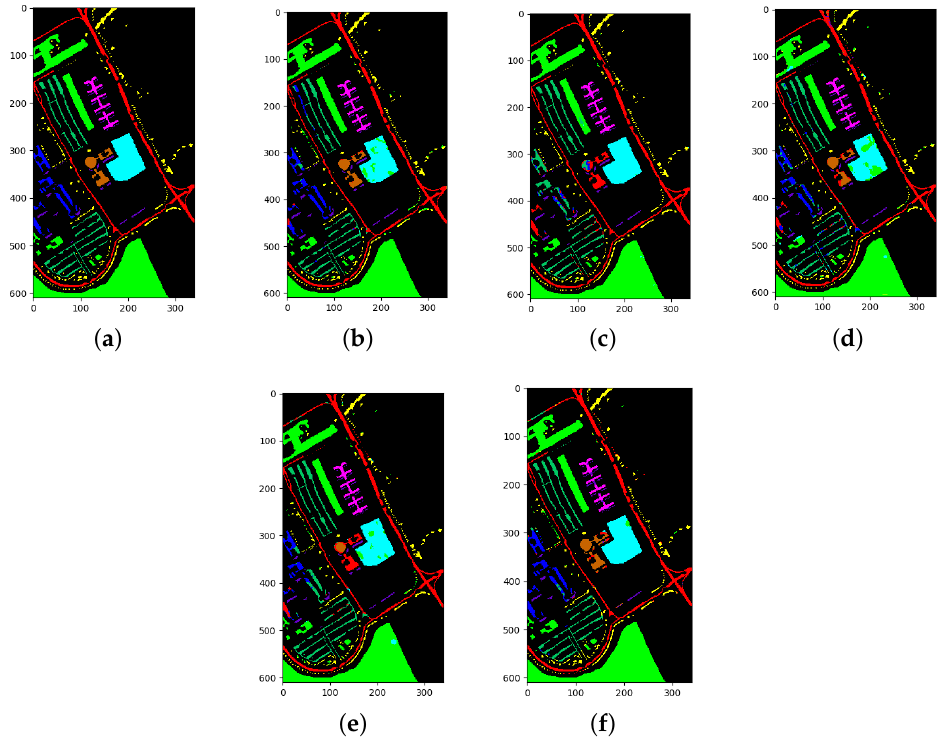
Figure 7. Classification maps for the PU dataset: ( a ) ground truth (GT); ( b – f ) results from the different algorithms. ( a ) GT; ( b ) SSRN; ( c ) FDSSC; ( d ) DBMA; ( e ) DBDA; ( f )